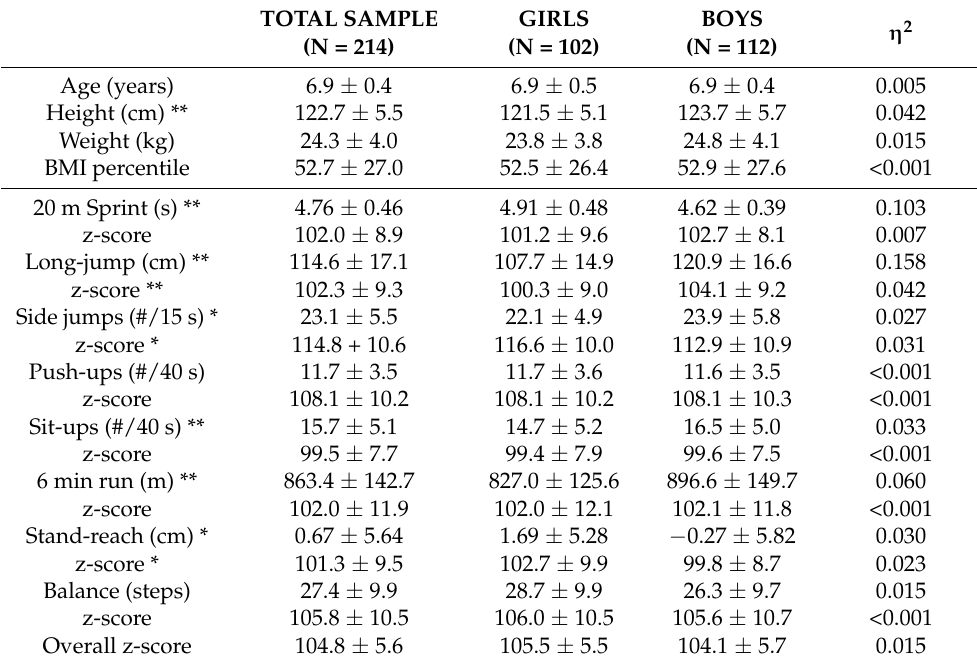
Table 1. Baseline